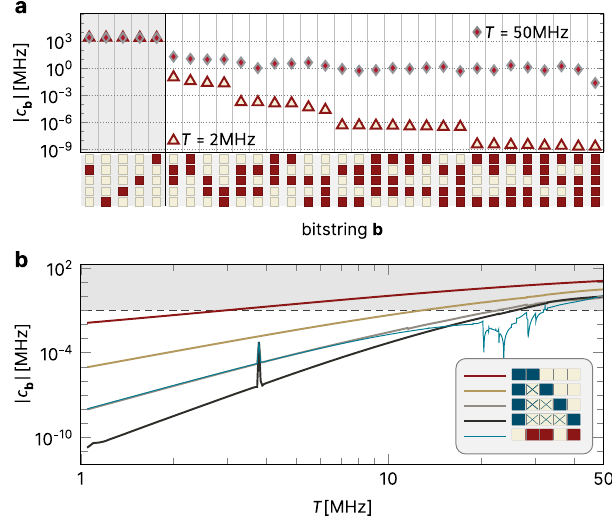
Fig. 5 Walsh-transform analysis. a Comparison of the c b coef fi cients of Eq. (6) for a fi ve-qubit chain with scheme- A parameters, for two values of the coupling T . Along the x -axis, are the 31 different values of the bitstring b with at least one non-zero bit. We use a graphical depiction of each bitstring, as a vertical column of fi ve boxes, so that the fi rst bitstrings, starting from the left, are 01000, 00001, 00010, etc. With this graphical depiction, one can see immediately which of the fi ve transmons are involved in the given τ -Hamiltonian coef fi cient. The ∣ c b ∣ are sorted from largest to smallest for the T = 2 MHz data, which reveals a clear hierarchy of strengths according to the maximal distance between two 1 ’ s in the bitstring. There is no such systematic behavior for the large- T case (plotted for the same ordering). b Absolute value of averaged Walsh coef fi cients as a function of the coupling T . The inset introduces a new coloring notation for the bitstrings b ; blue-colored bit boxes indicate that the c b shown is averaged over all cases with the same maximal distance of two 1 ’ s. The convention is explained more fully in the Methods section, Fig. 9. Also shown for comparison is the absolute value of the Walsh coef fi cient for the speci fi c bitstring b = 01101. The dashed line and the shading above mark the “ danger zone ” ∣ c b ∣ ≳ 100 kHz indicated by recent experimental studies on ZZ coupling 3